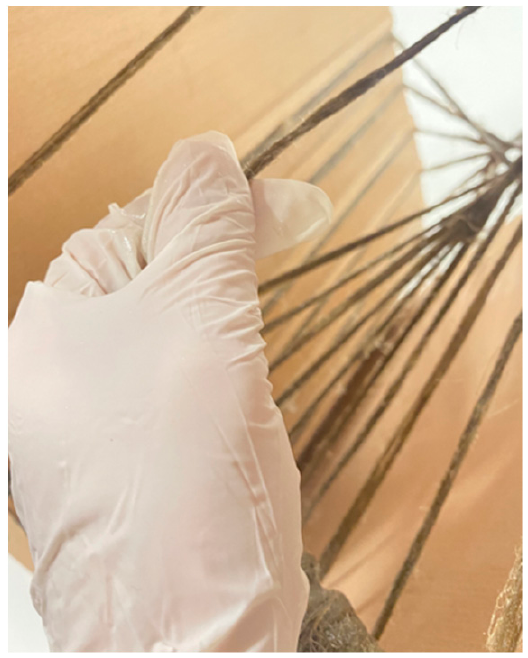
Figure 17. In situ timber lamination of the seat surface, to connect ends and achieve desired curved geometry.